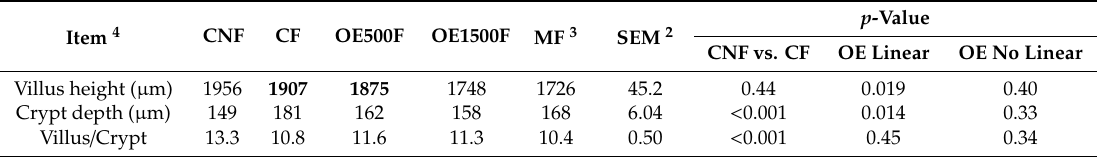
Table 7. E ff ect of a short-term (15.5 h) fasting period and experimental diets on villus height, crypt depth and villus / crypt ratio in broiler chickens duodenum at 15 d of age.